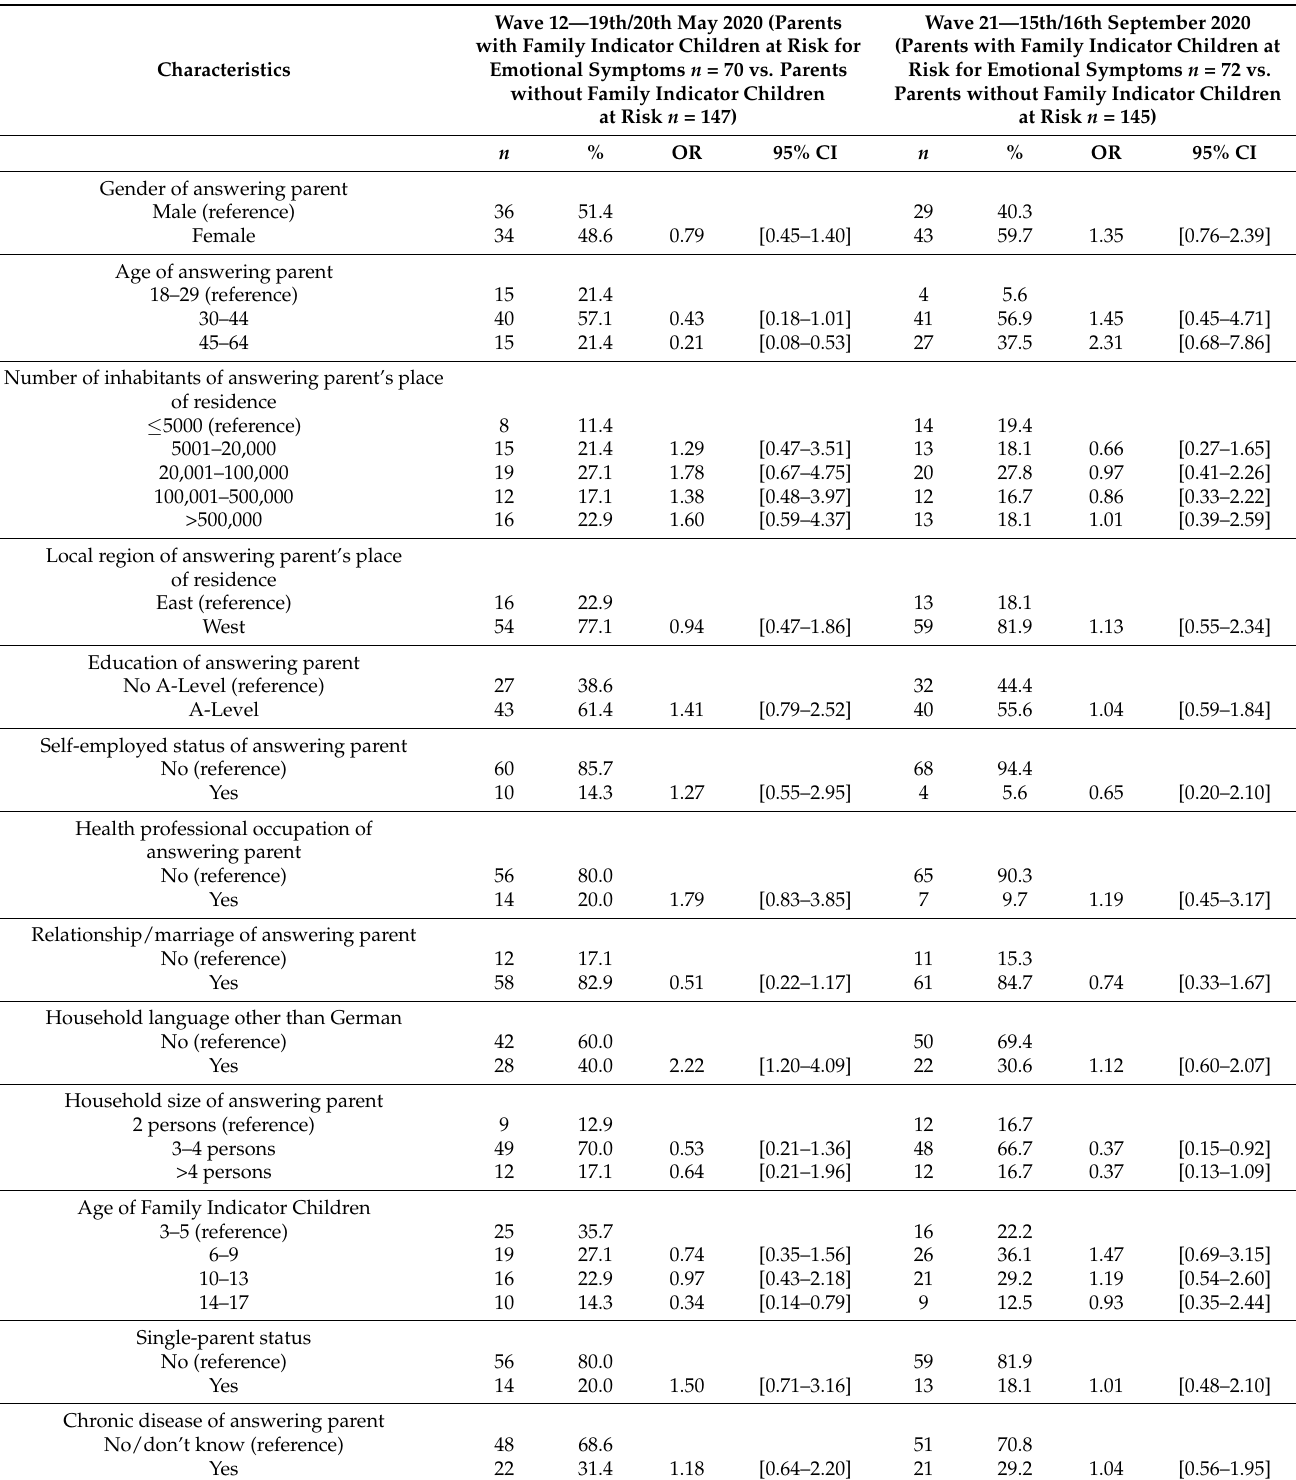
Table 2. Univariate analysis—absolute and relative frequencies and odds ratios of parents with family indicator children and adolescents at risk for emotional symptoms based on the SDQ